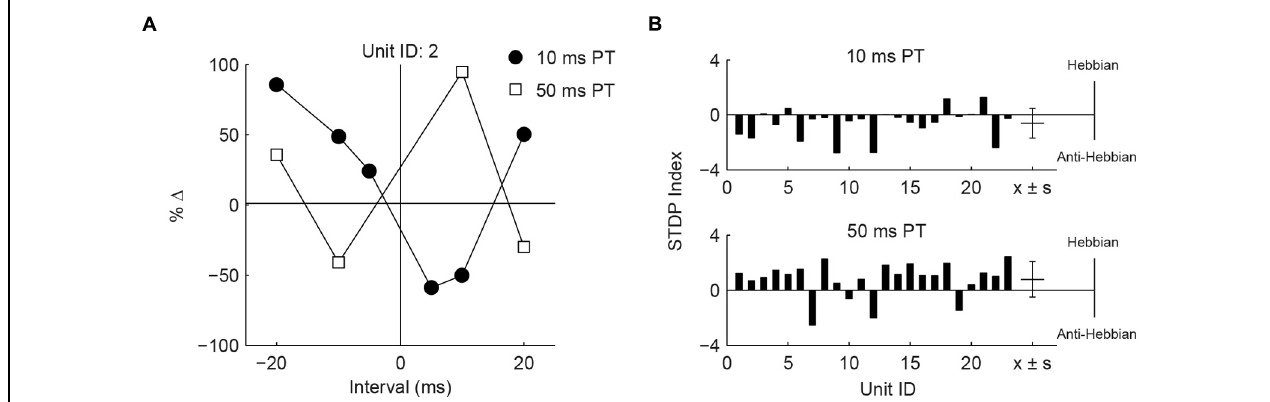
FIGURE 5 | Hebbian or anti-Hebbian timing rules can be induced in the same units using different duration PTs. (A) Timing rules induced by neck/dorsal column stimulation paired with 10 and 50 ms PTs in a representative unit. (B) STDP indices of 23 units using 10 ms PT (upper panel) or 50 ms PT (lower panel). Mean ± SD ( x ± s ) STDP indices shown on the right.